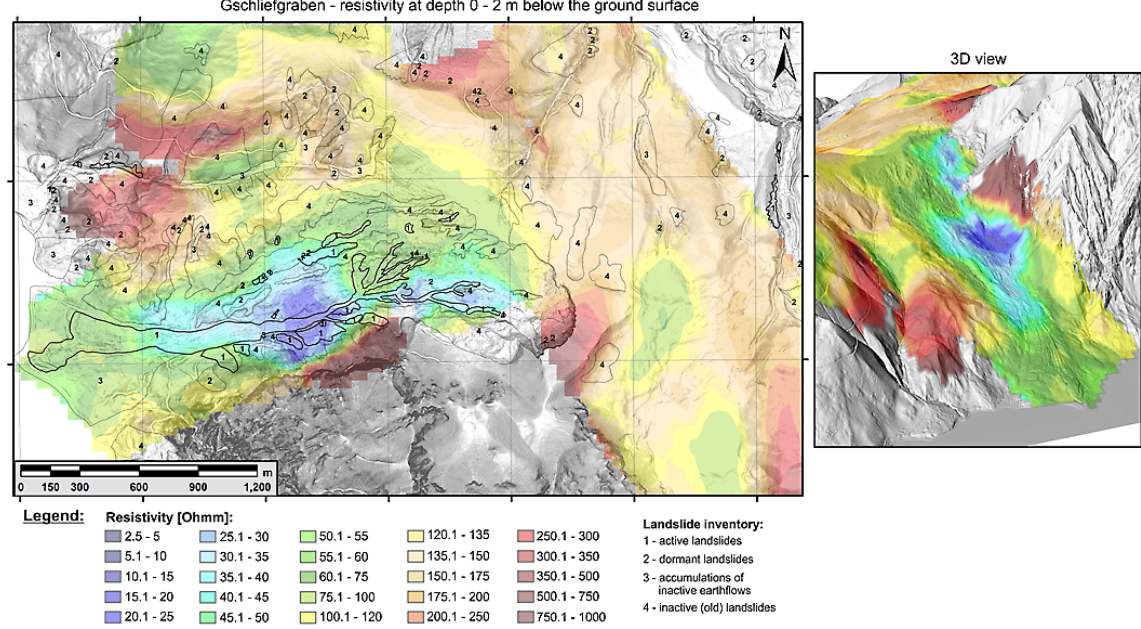
Fig. 6. Map of the subsurface resistivity derived from AEM data (depth slice) at depth 0–2m below the ground surface compared to the landslide inventory map; right side: 3-D view from the west.